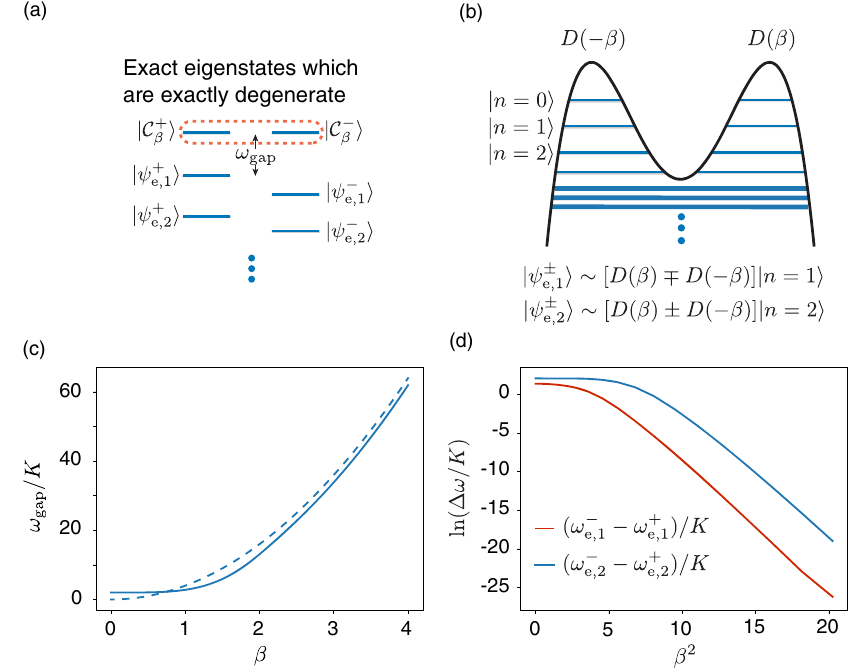
FIG. 2. (a) Illustration of the eigenspectrum of the PCO. (b) In the limit of large parametric drive P or, equivalently, large β , the PCO effectively behaves like two harmonic oscillators displaced by (cid:3) β . The states confined in the harmonic potentials are the Fock states j n ¼ 0 i , j n ¼ 1 i , etc. The tunneling between the two potentials is exponentially suppressed, and, therefore, the eigenspectrum of reduces to superpositions of pairs of degenerate displaced Fock states ½ D ð β Þ (cid:3) D ð − β Þ(cid:2)j n i . There, of course, exist higher excited states which are not confined in the harmonic oscillator potential and cannot be described in such a simple manner. (c) The energy gap obtained by exact diagonalization of Eq. (5) (solid blue line) and the approximate gap 4 K β 2 (dashed blue line). As expected, the solid blue line converges to 2 K as β decreases. The approximate expression converges to the exact gap for large β , but it breaks down for small β where the exact energy gap is 2 K . (d) Logarithmic (base e ) plot of the energy difference between the first two (red) and second two (blue) excited states of the Hamiltonian in Eq. (5) as a function of β 2